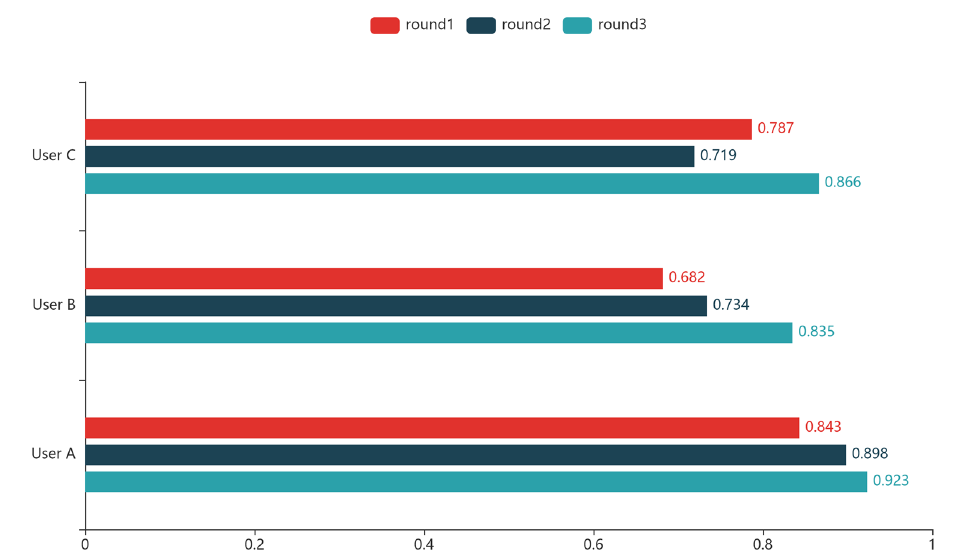
Figure 11. Accuracy of junior doctor users in three rounds exercise.